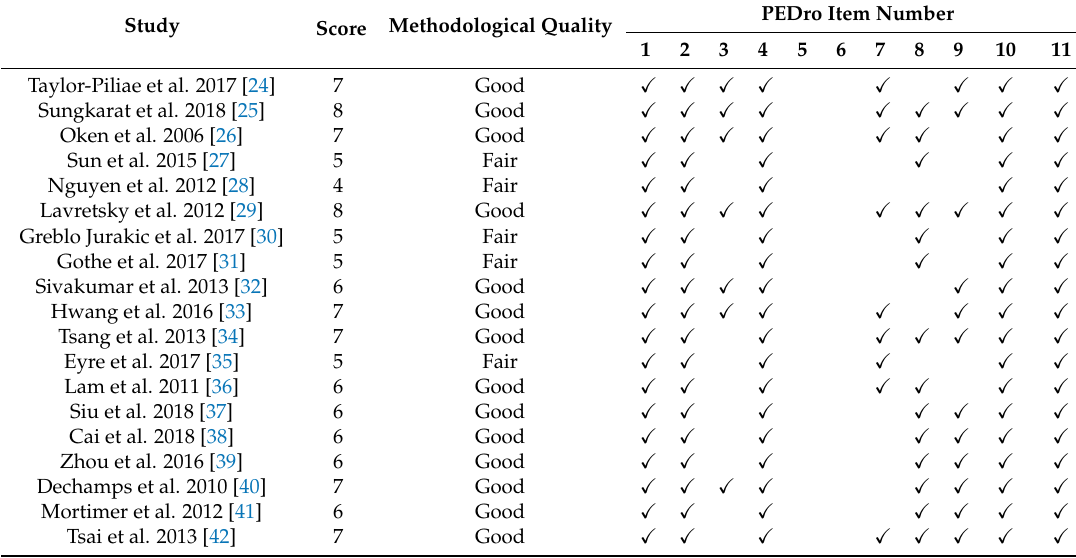
Table 2. Methodological quality of the included studies (PEDro